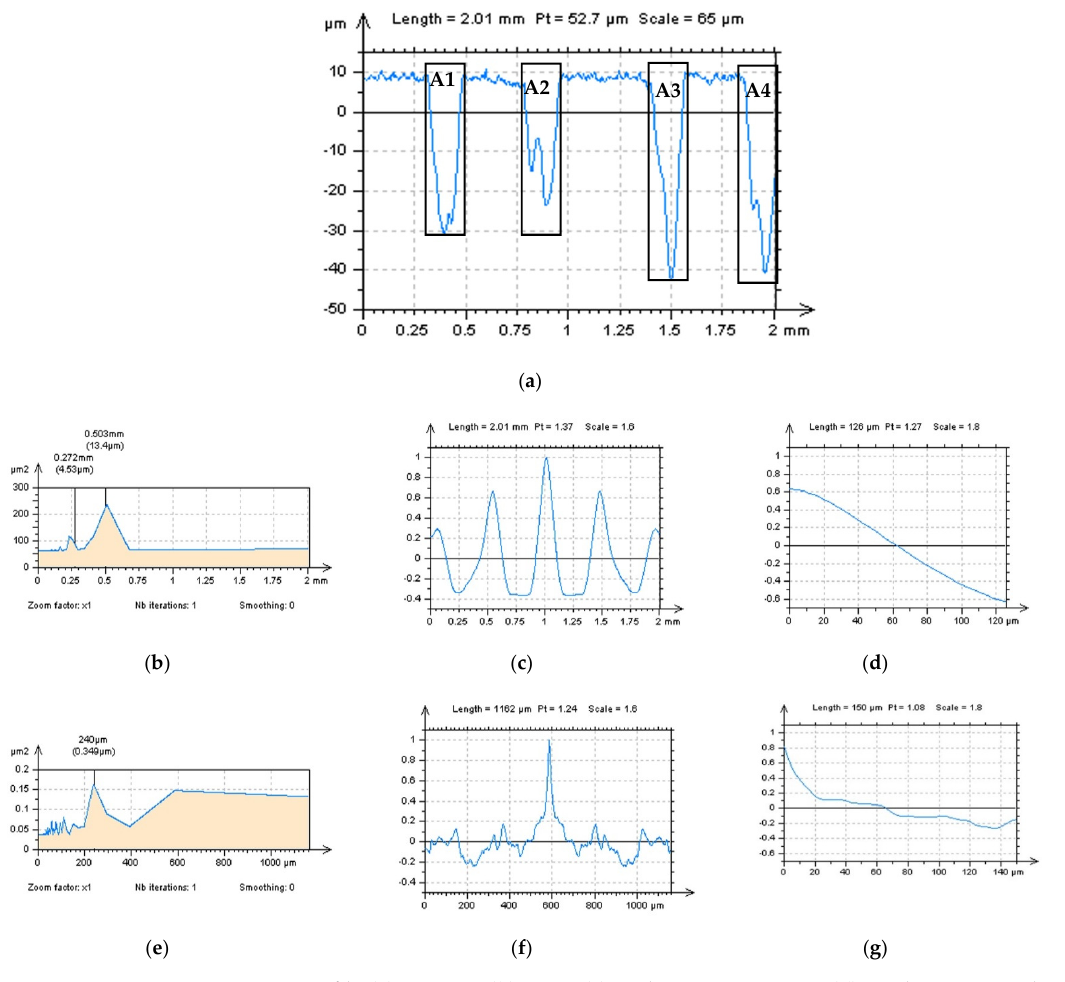
Figure 3. Profile ( a ), its PSD ( b ), ACF ( c ) and centre ‐ part ACF ( d ), and, correspondingly, PSD ( e ), ACF ( f ) and its centre ‐ part ACF ( g ) of profile with thresholded A1 ‐ A2 ‐ A3 ‐ A4 parts from primary profile from ( a ) sub ‐ figure; profile extracted from 120 ‐ angle LST detail containing an HFN.